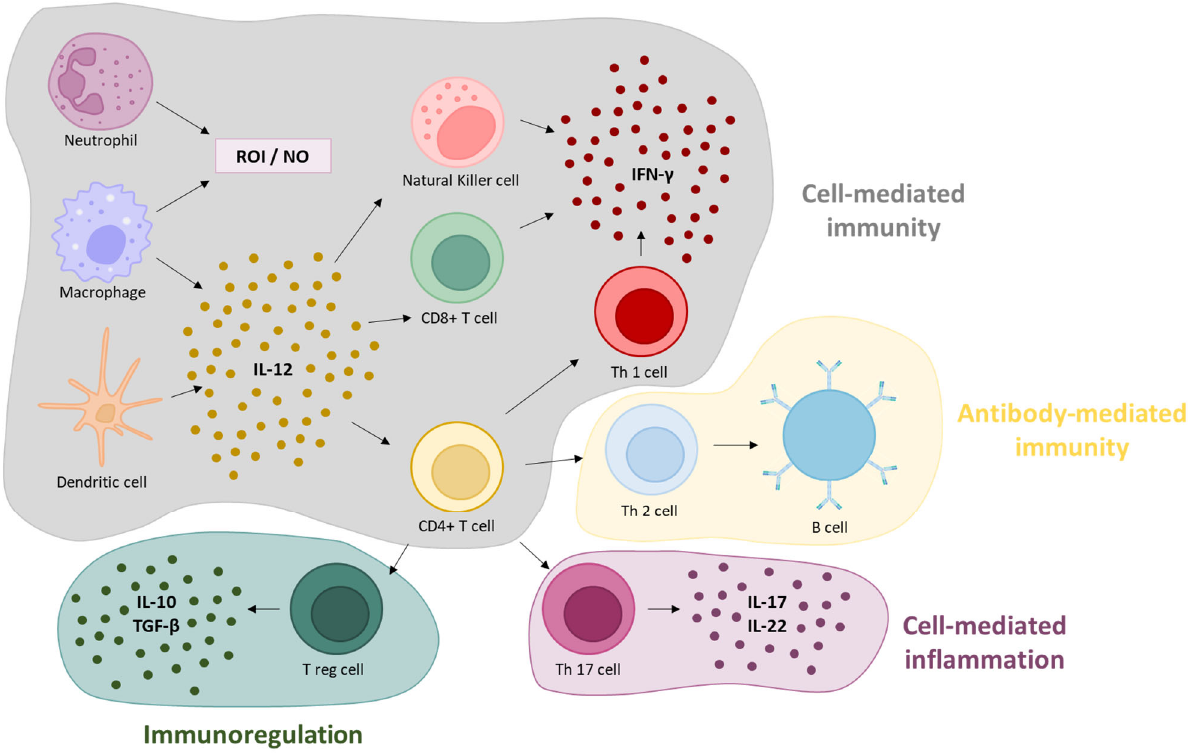
Figure 2. T. gondii immune response. Neutrophils and macrophages phagocytize and kill the parasite by releasing antimicrobial compounds and by producing ROI and NO. Macrophages produce IL-12 activating NK cells and T cells to produce INF- γ . DCs phagocyte the parasite and migrate to lymphoid organs where they present their antigens via MHC I or II to CD8 + cytotoxic T lymphocytes or CD4 + helper T cells, respectively. CD8 + CTL will kill the infected cells by apoptosis, and CD4 + T cells undergo activation and maturation towards a strong Th1 or Th17 response, through the production of IL-17, IL-21, or IL-22. NK, CD8 + T cells and Th1 cells produce IFN- γ , controlling infection. Th2 cells secrete cytokines that stimulate B lymphocytes and consequently the production of antibodies, allowing tachyzoite phagocytosis.